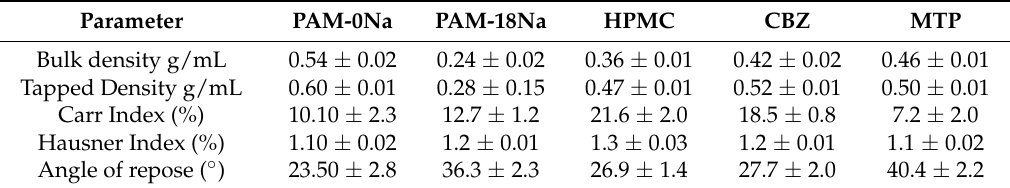
Table 1. Powder properties of the study